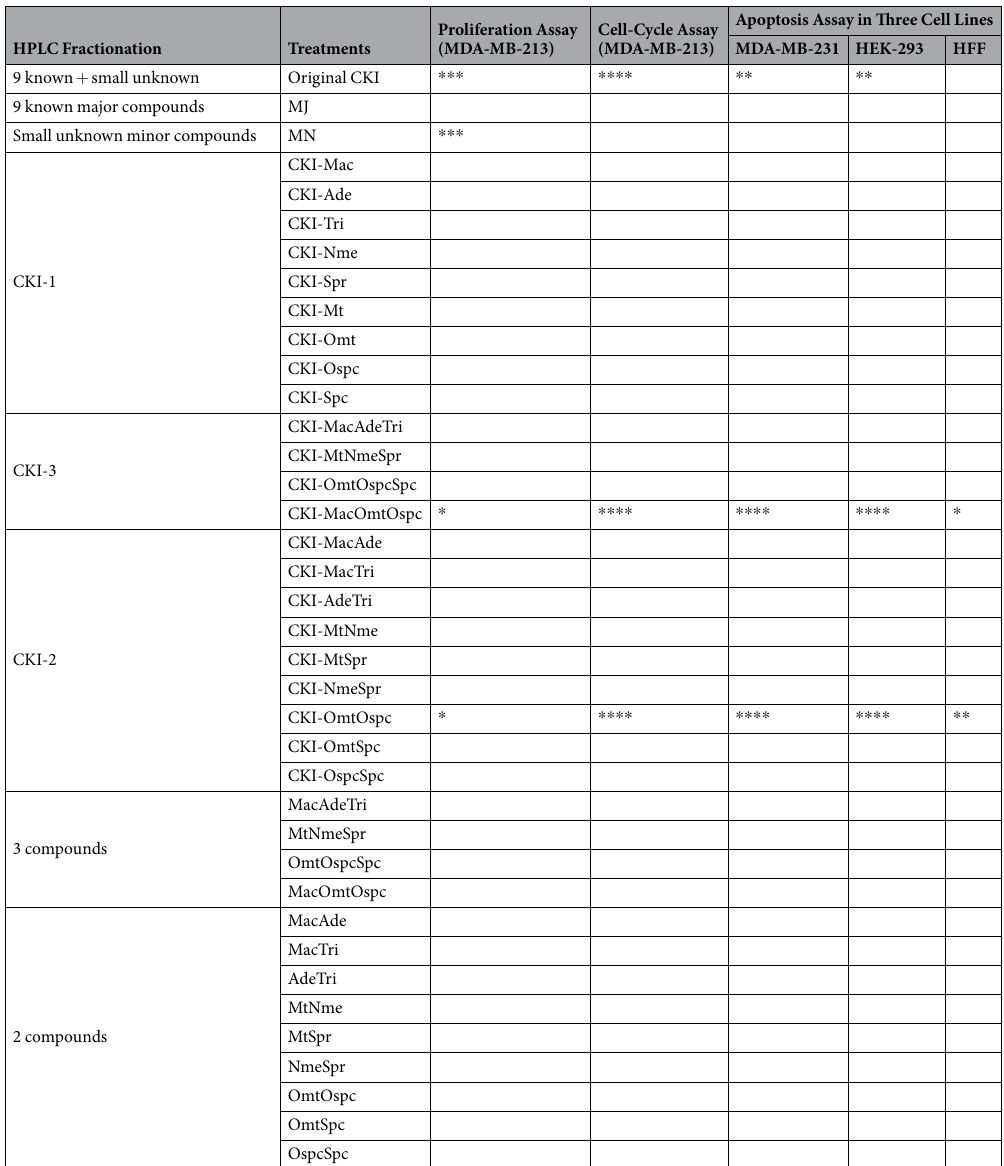
Table 1. Summarised results of HPLC fractionation and treatments using three cell-based assays at 48-hour from Figs 2 and 3 and Supplementary Fig. 2. Statistically significant results of CKI treatment were calculated based on comparison against UT whereas those of other treatments were calculated based on comparison against corresponding CKI treatments. Statistically significant results were represented as ( * )P < 0.05 or ( ** ) P < 0.01 or ( *** )P < 0.001 or ( **** )P <